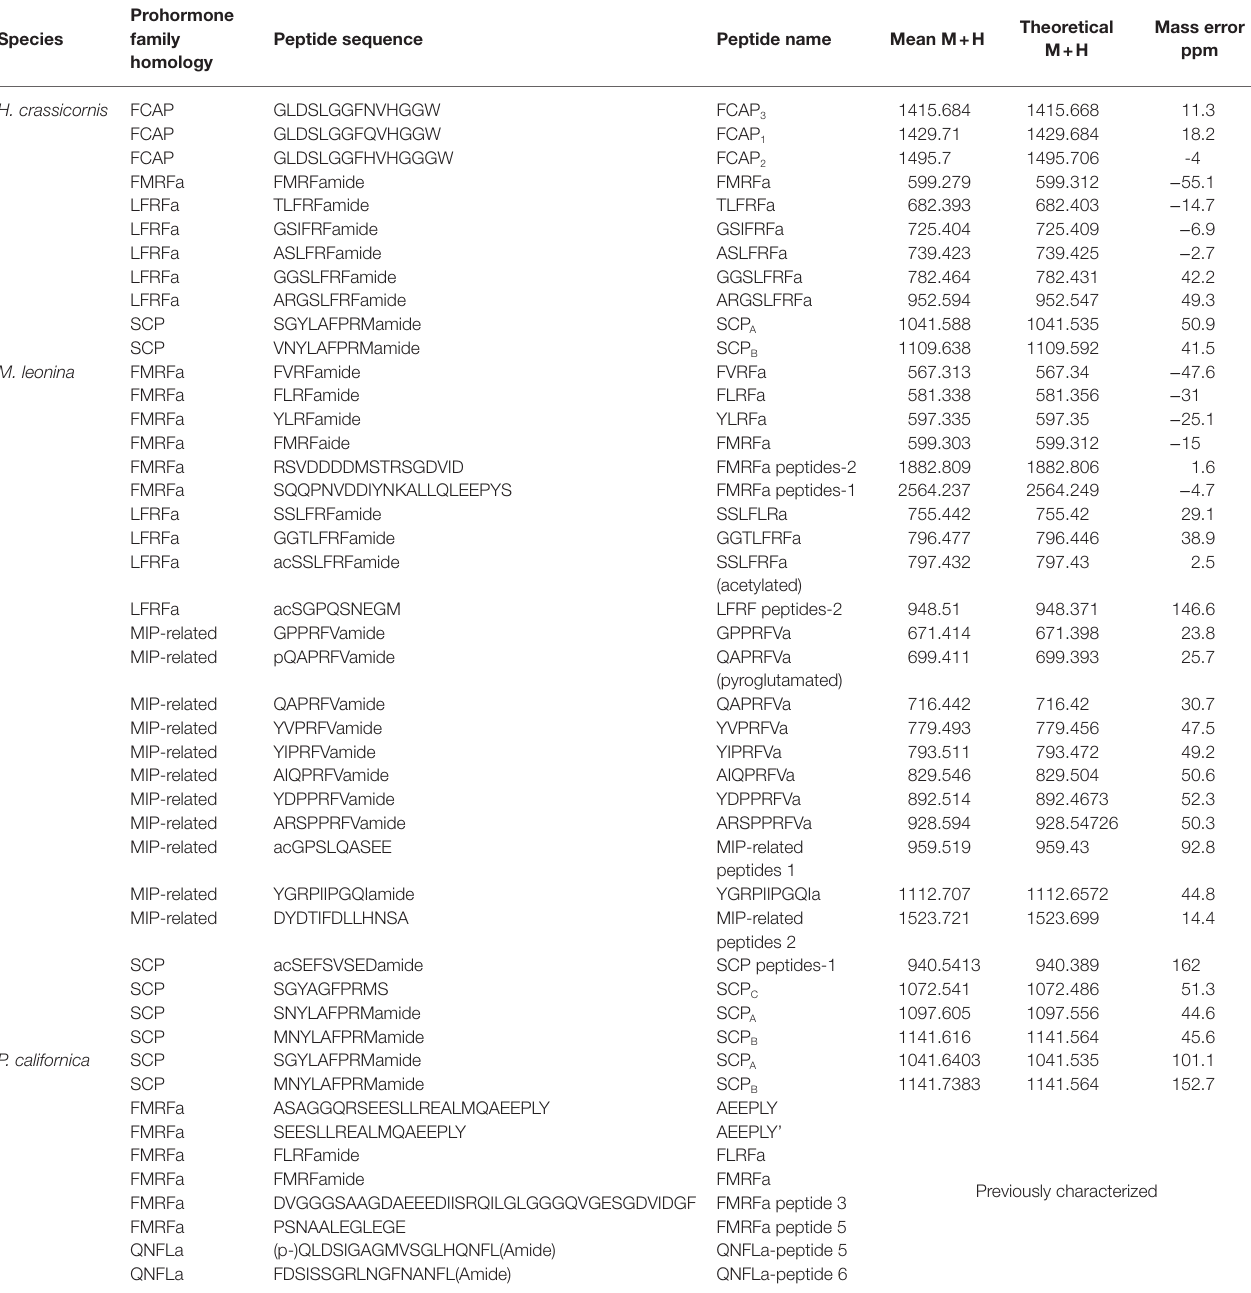
TABLE 2 | MALDI-TOF MS identification of neuropeptides in SLB cells/VWCs of nudipleurans. Prohormone Species family